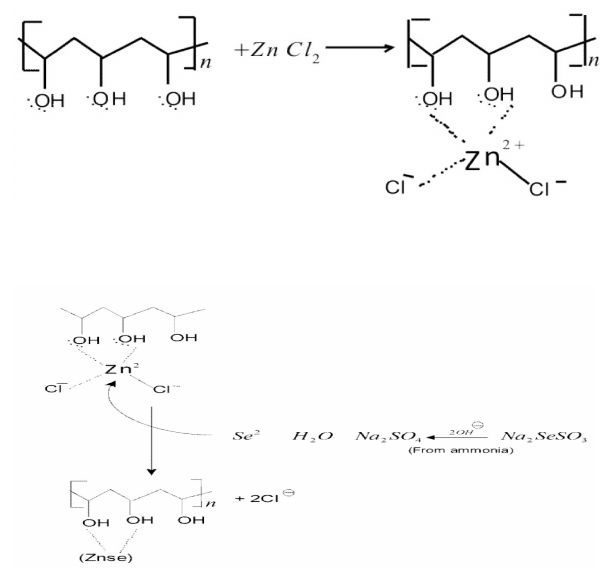
Table 1: The weight of various compounds used for preparing ZnSe/PVA composite films